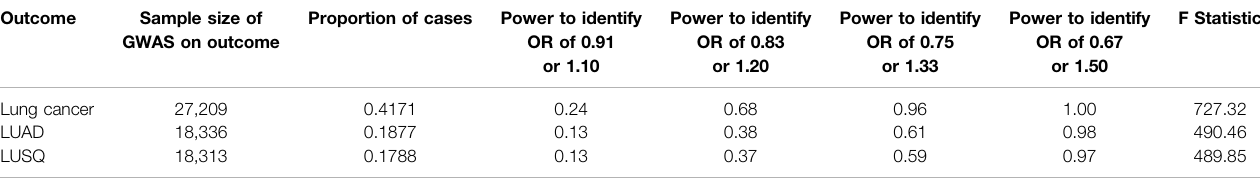
TABLE 3 | Mendelian randomization estimates of the causality between insomnia and lung